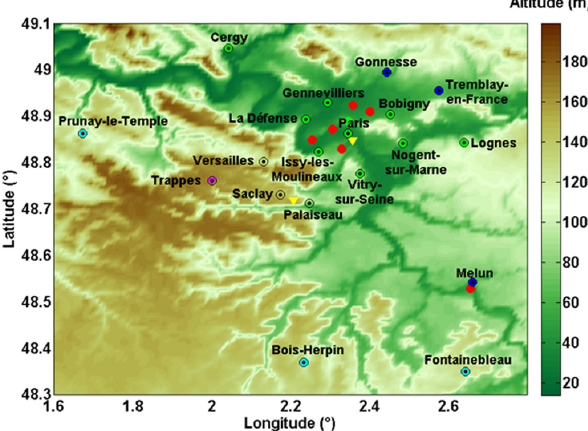
Fig. 1. Topographic map with the main cities in the vicinity of Paris. Colored circles indicate rural (in cyan), peri-urban (in blue), urban (in green) and traffic (in red) AIRPARIF stations measuring PM 10 . Paris and Palaiseau AERONET sun-photometer stations and the location of Trappes radiosoundings are also indicated by yellow and pink triangles,